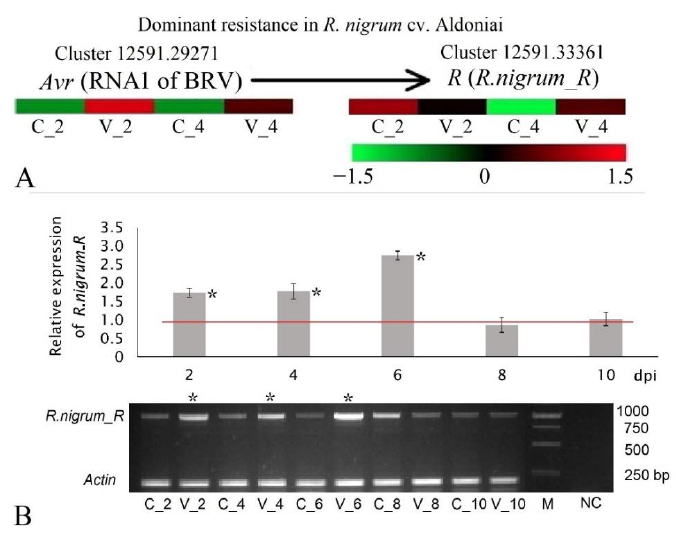
Figure 5. Gene expression in Avr - R resistance system of blackcurrant cv. Aldoniai based on RNA-seq ( A ) and qRT-PCR ( B ). Control (mock-inoculated at 2–10 dpi) samples C_2–C_10; treated (BRV- inoculated at 2–10 dpi) samples V_2–V_10; M—mass ruler, NC—negative control in the agarose gel, *—treatment with positive qRT-PCR reaction of BRV. Significant expression level log2FC > 1 in heatmap ( A ); significant expression level 2 − ∆∆ C T > 1 is separated by a red line in the bar chart ( B